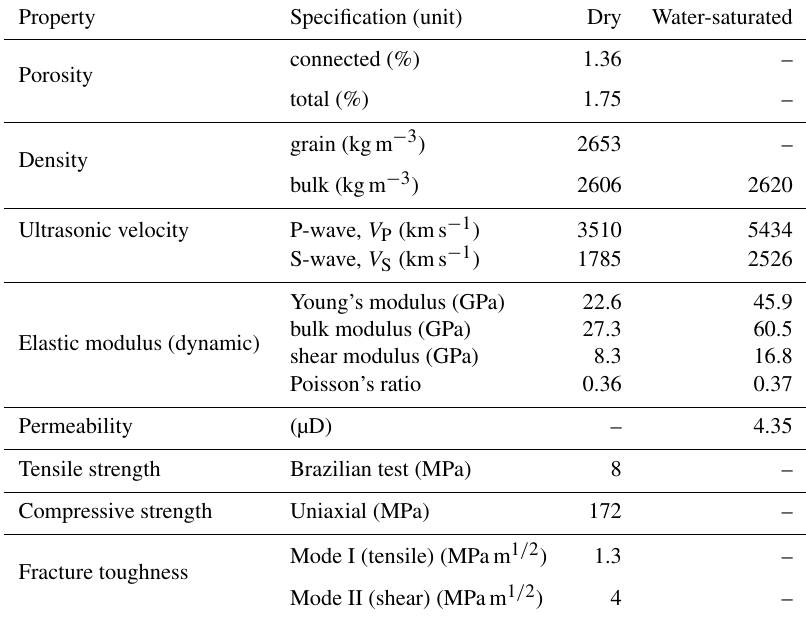
Table 4. Selected physical properties of the Rotondo granite (measured under no confining